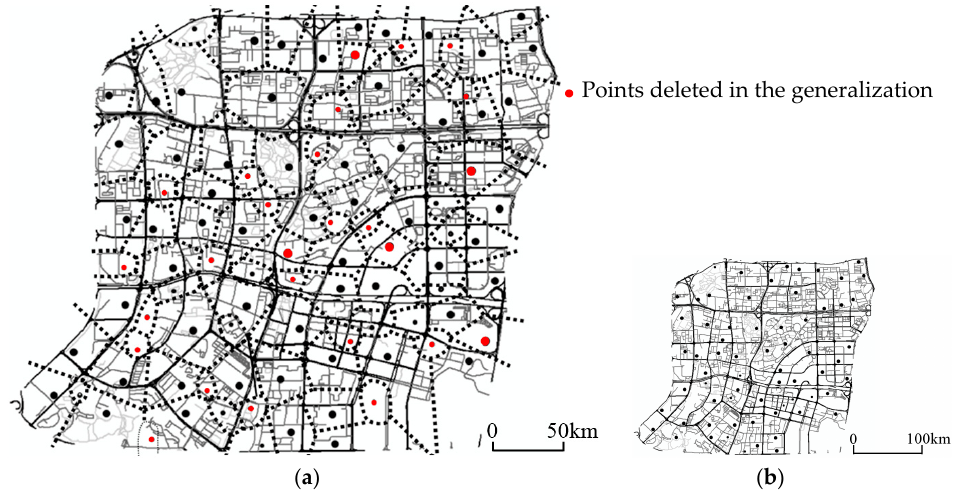
Figure 15. Experiment 2 for testing the algorithm based on the weighted Voronoi diagrams and comparing it with the new algorithm: ( a ) weighted Voronoi diagram of point cluster and ( b ) generalized point cluster. The maps are not shown exactly to scale.